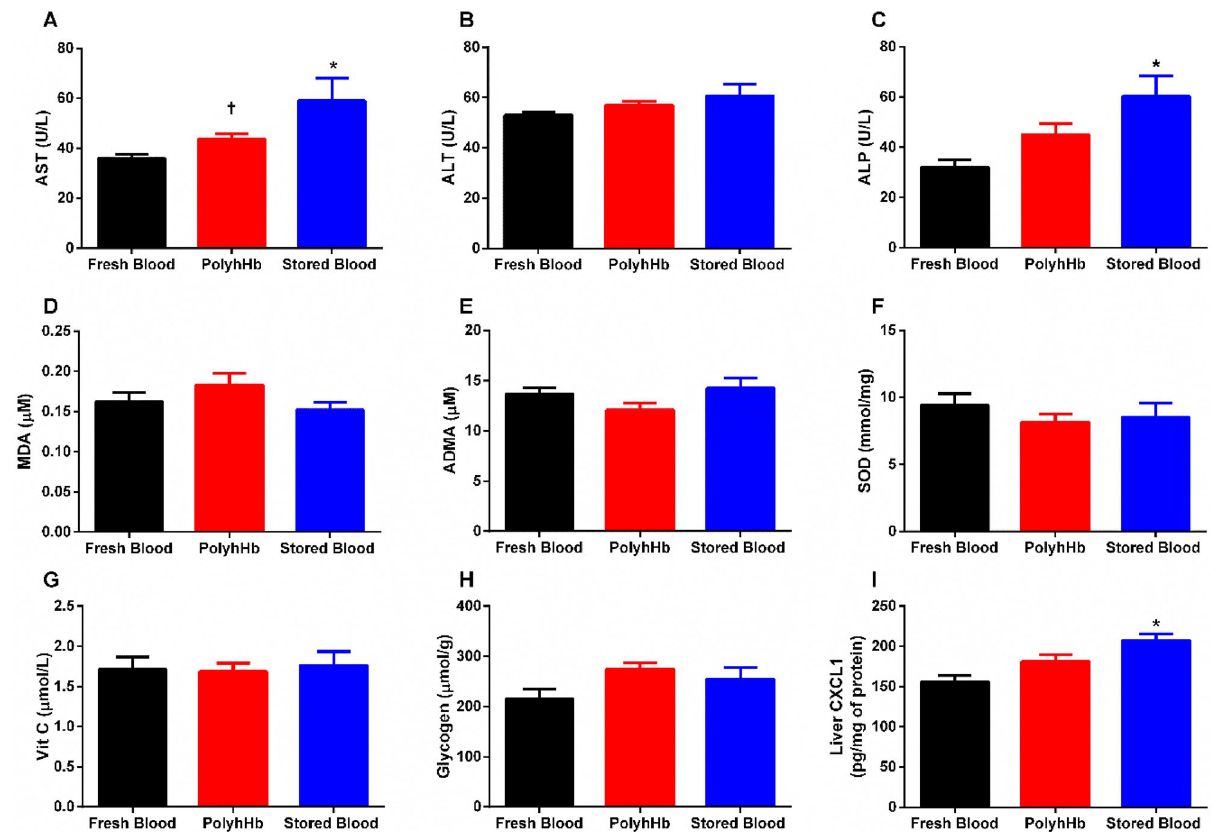
Figure 2. Markers of liver function after resuscitation. These results indicate that animals resuscitated with stored blood presented an increased risk for liver damage at 24 h after resuscitation, while resuscitation with PolyhHb do not seem to drastically impair liver enzymes. ( A ) Aspartate aminotransferase (AST); ( B ) Alanine aminotransferase (ALT); ( C ) Alkaline phosphatase (ALP); ( D ) Malondialdehyde (MDA); ( E ) Asymmetric dimethylarginine (ADMA); ( F ) Superoxide dismutase (SOD); ( G ) Vitamin C (Vit C); ( H ) Glycogen; ( I ) Liver chemokine ligand 1 (CXCL-1). Measurements were taken 24 h after resuscitation. *, p < 0.05 versus Fresh Blood; †, p < 0.05 versus Stored Blood. Statistical comparisons were completed using a one way- ANOVA; Tukey’s multiple comparison test.